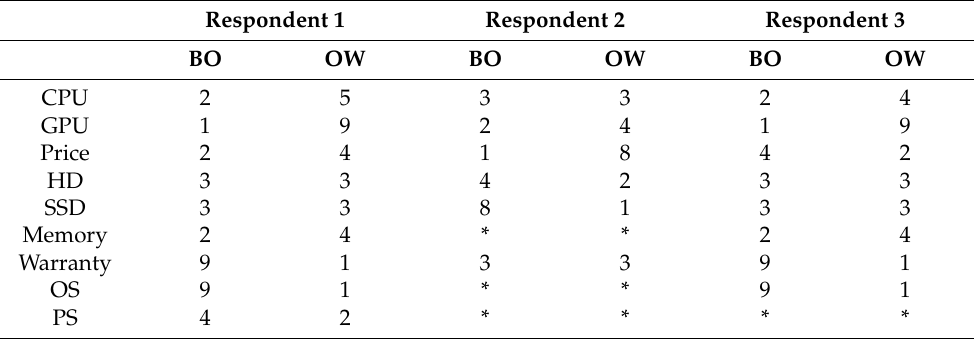
Table 7. BO vectors and OW vectors for the three respondents.